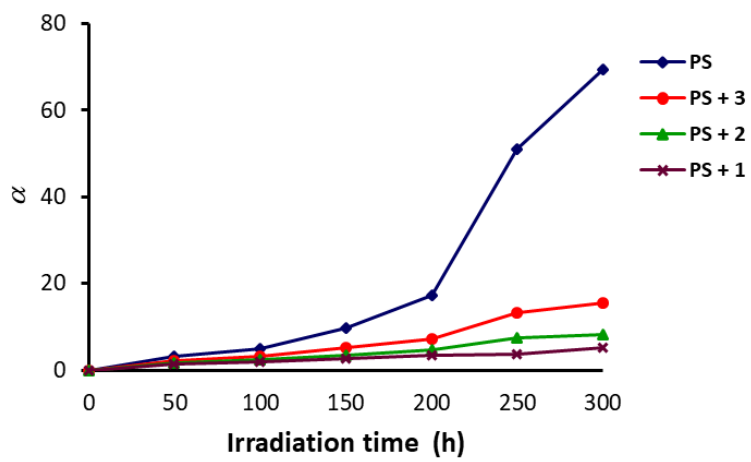
Figure 9. Changes in the α of PS upon irradiation.